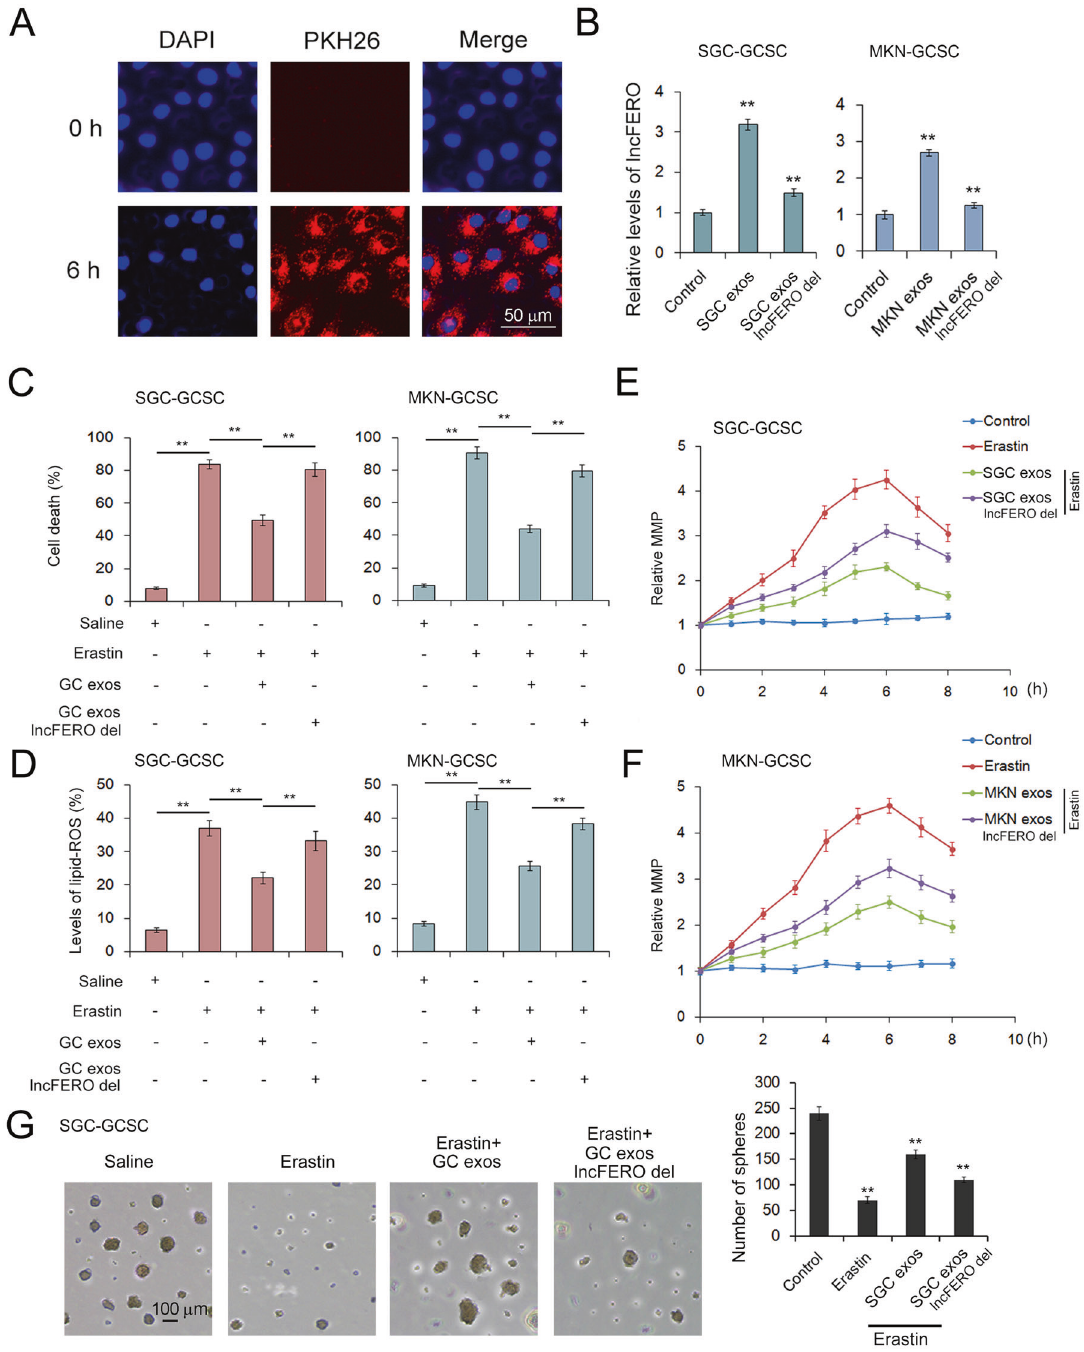
Fig. 4 Exosome-delivered lncFERO suppresses ferroptosis in GCSCs. A Confocal microscopy image of the internalization of fl uorescently labeled GC exosomes in GCSCs. B Effects of GC exosomes on lncFERO levels in GCSCs ( n = 3). C – F Exo-lncFERO derived from GC cells suppresses erastin-induced ferroptosis in GCSCs. GC exo-lncFERO decreases erastin-induced cell death ( C ) ( n = 3), inhibits lipid ROS accumulation ( D ) ( n = 3), and reduces abnormal increases in MMP ( E , F ) ( n = 3). G Effects of erastin and exo-lnc-FERO on sphere formation of GCSCs ( n = 3). ** p <